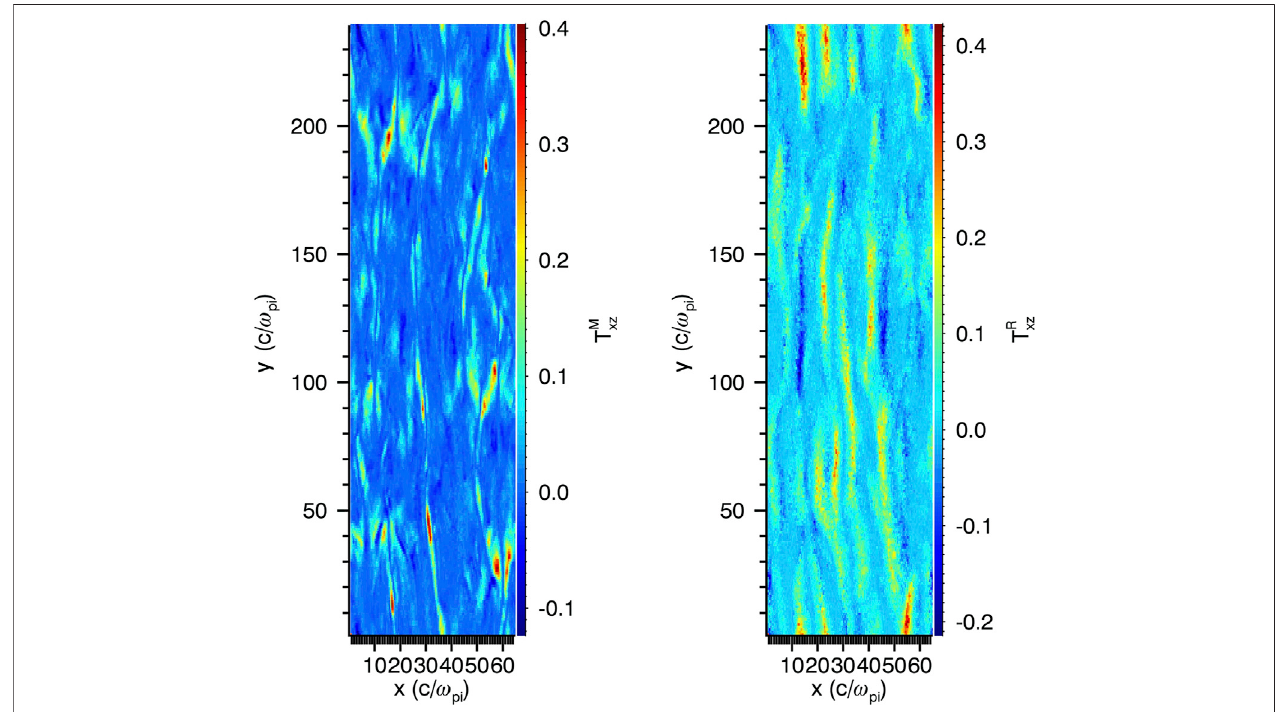
FIGURE 7 | Maxwell and Reynolds stresses (normalized) at the magnetopause boundary in a 3-D hybrid simulation.